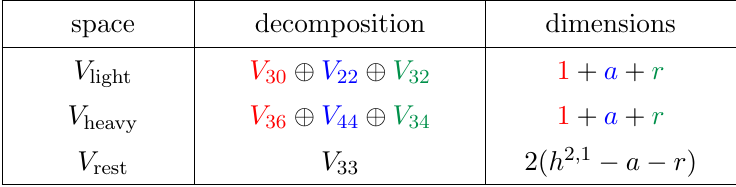
Table 4 . Decomposition of H 3 ( Y 3 ; R ) for I a ! IV d . Note again that we use colors to indicate the dimensions of individual subspaces.